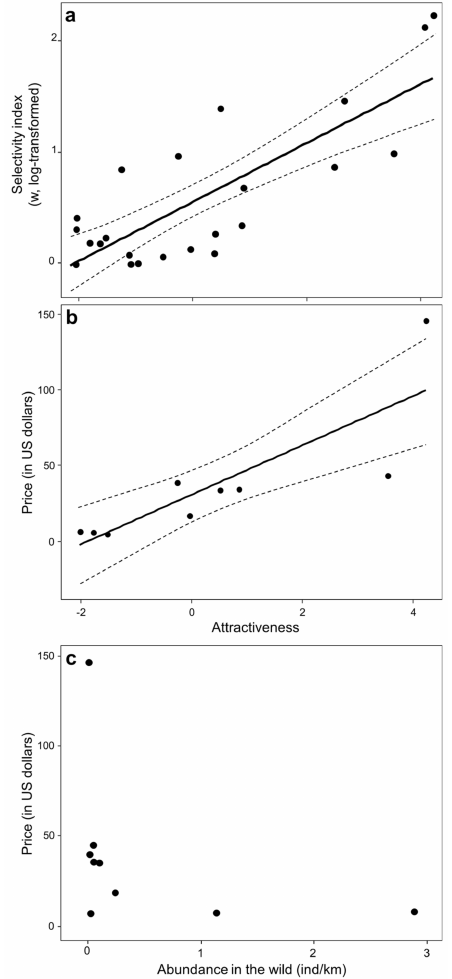
Figure 7. Preferred parrots in Colombia (measured through their Savage selective index) were the most attractive (i.e., large, colorful, and able to imitate human speech) species ( a ), which were also the most expensive ( b ), independently of their abundance in the wild ( c